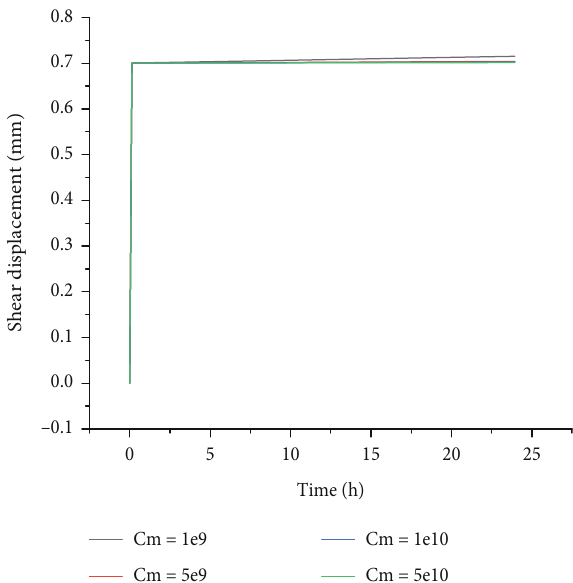
Figure 6: Shear displacement-time relation of unbolted joints m with under di ff erent C m